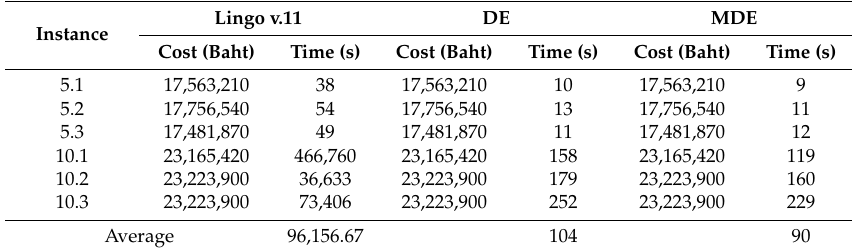
Table 11. Comparing results of DE and MDE algorithms with the optimal solution generated by Lingo v.11.